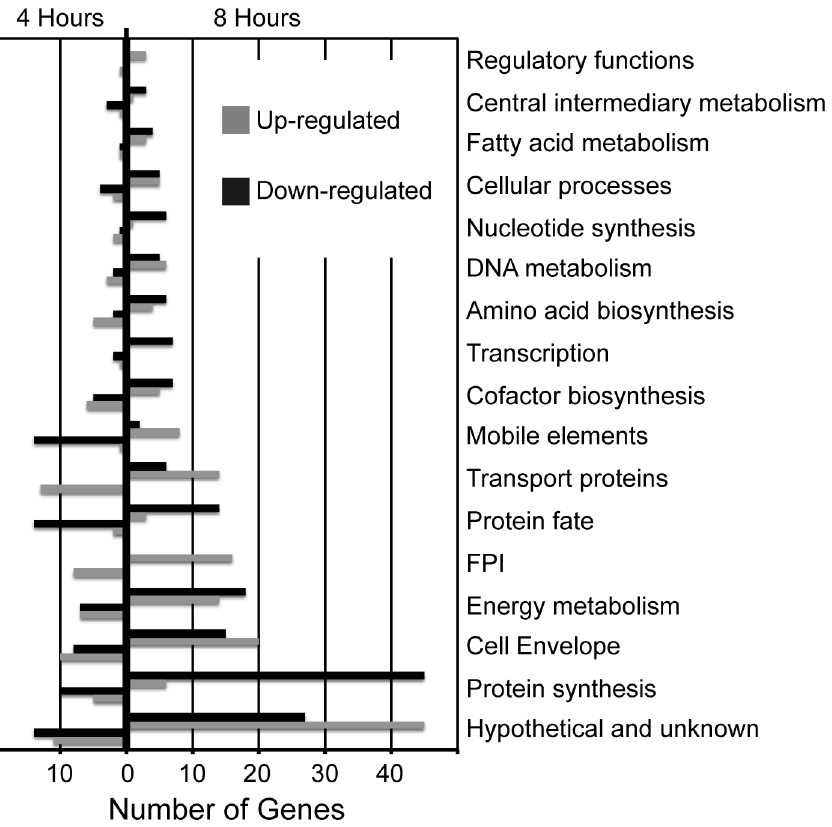
Figure 1. Number of genes up- and down-regulated, by functional category. All differentially expressed F . tularensis LVS genes were categorized by function, and the number of genes in each category were plotted according to whether their expression increased or decreased at 4 hours (left) and 8 hours (right) after